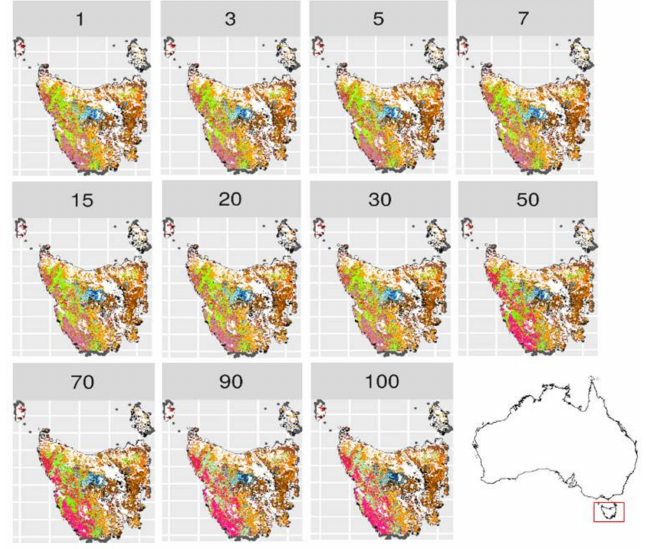
Figure 3. Impact of frequent fire (every 4 years) on vegetation type across Tasmania, incorporating annual layers from the Climate Futures for Tasmania projections. The numbers above each map refer to the number of years from 2000. Colors represent different vegetation types, as follows: Light blues, Subalpine vegetation; Dark blue, Alpine vegetation; Purple, Buttongrass; Oranges, Wet sclerophyll; Dark Orange to Brown, Dry sclerophyll; Greys, Woodland; Reds, Non-eucalypt wet forests; Dark Purple, Non-eucalypt dry forests, Light to Dark Greens, Rainforest.